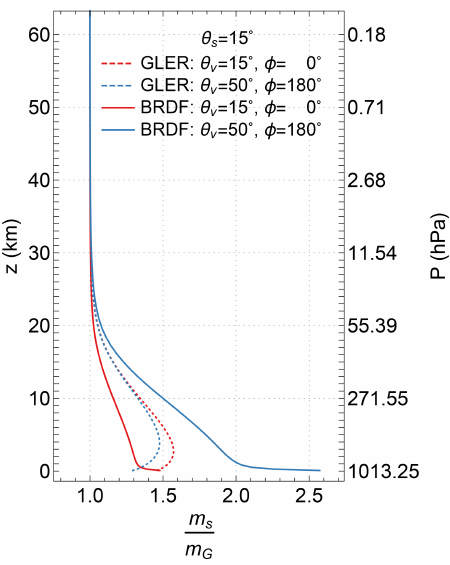
Figure 5. Mean path lengths ( m s ) of EPIC band 1 reflective photons from an ocean surface (with the same BRDF described in Fig. 4) and its Lambertian equivalent surfaces. Here the mean path lengths m s , normalized by the respective geometric air mass factors ( m G ), are plotted as functions of altitude z for two viewing illumination geometries: one view from the direction of specular reflection at θ v = 15 ◦ and φ = 180 ◦ and the other at θ v = 50 ◦ and φ = 0 ◦ , while the Sun is at θ s = 15 ◦ for both geometries.